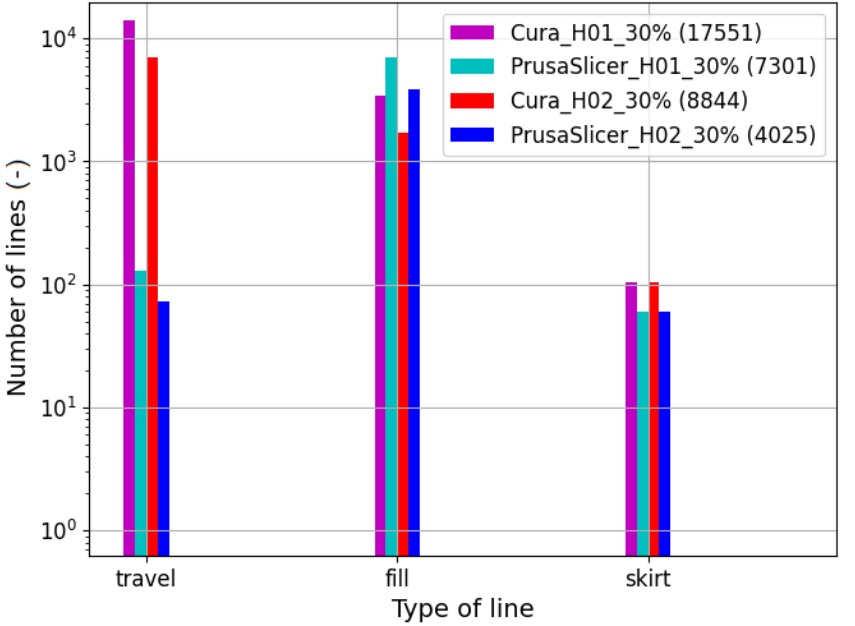
Figure 1. Number of lines for various types of extruder movements. Apart from the name of the studied case, the legend also contains in the brackets the total number of analyzed